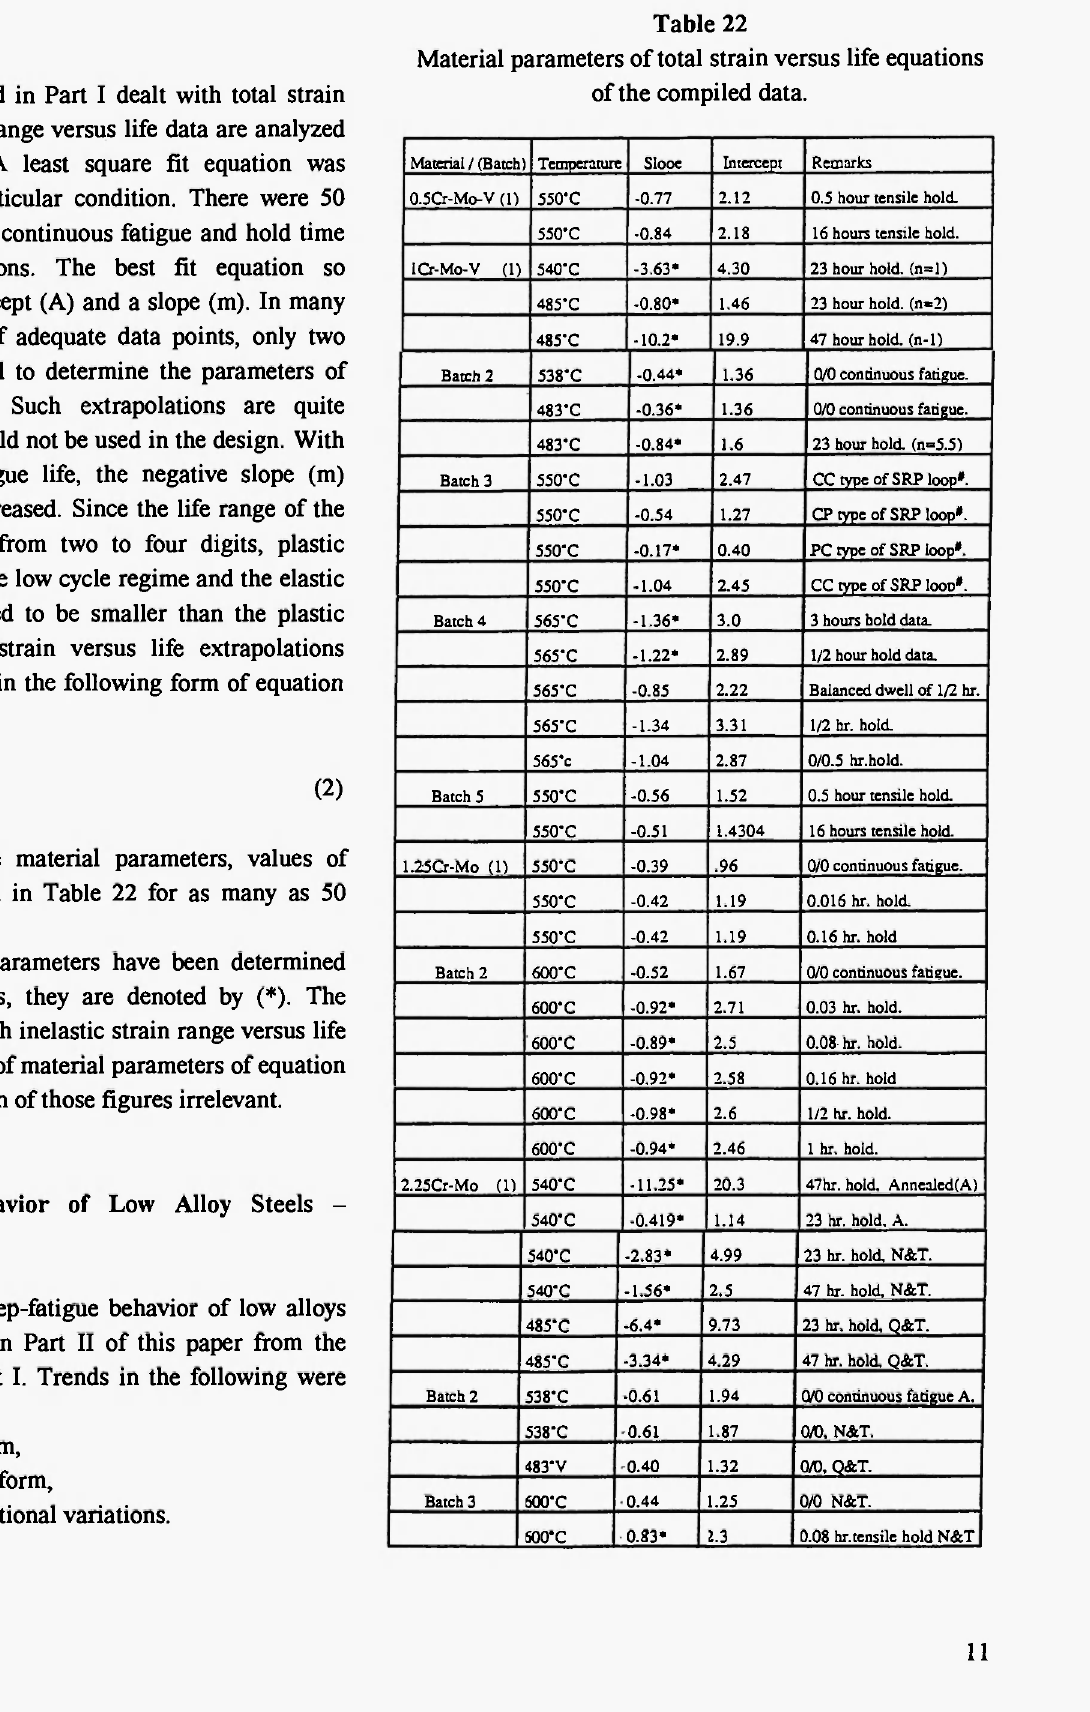
Material parameters of total strain versus life equations of the compiled